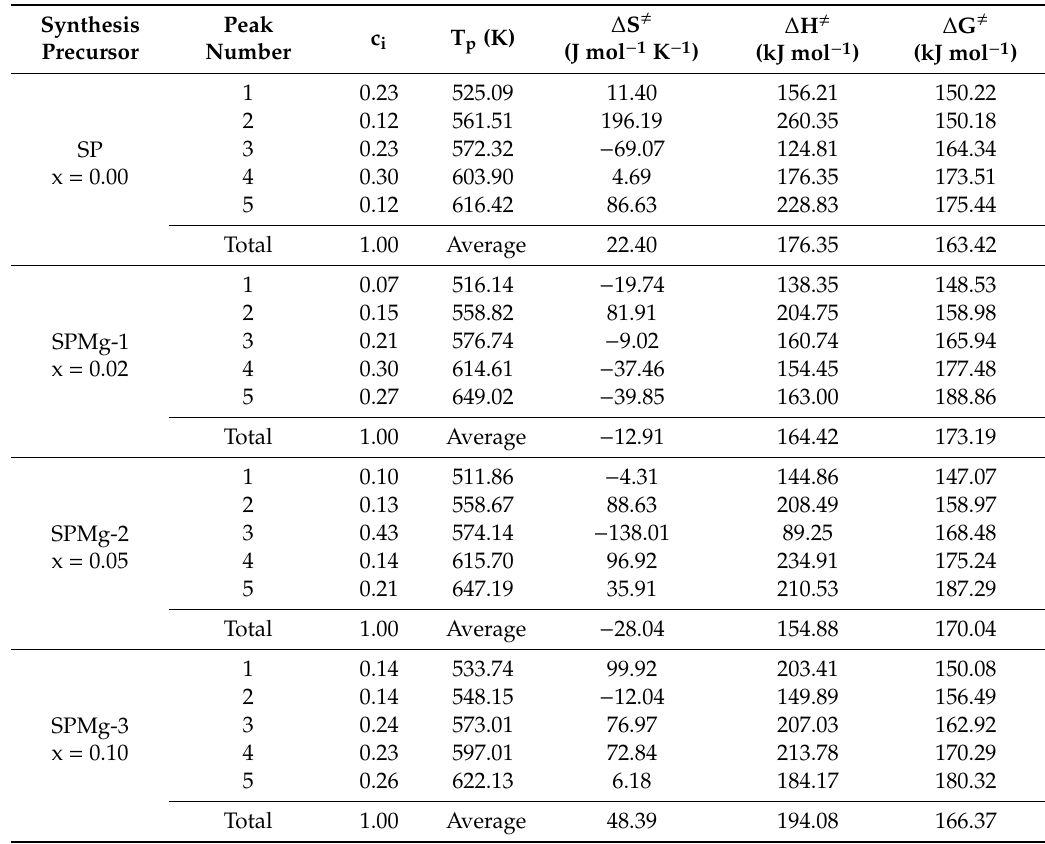
(cid:44) (cid:44) (cid:44) Table 4. The ∆ S , ∆ H , and ∆ G values for formation of activated complexes in the polymeric matrix thermal decomposition zone of doped synthesis precursors with di ff erent concentrations of